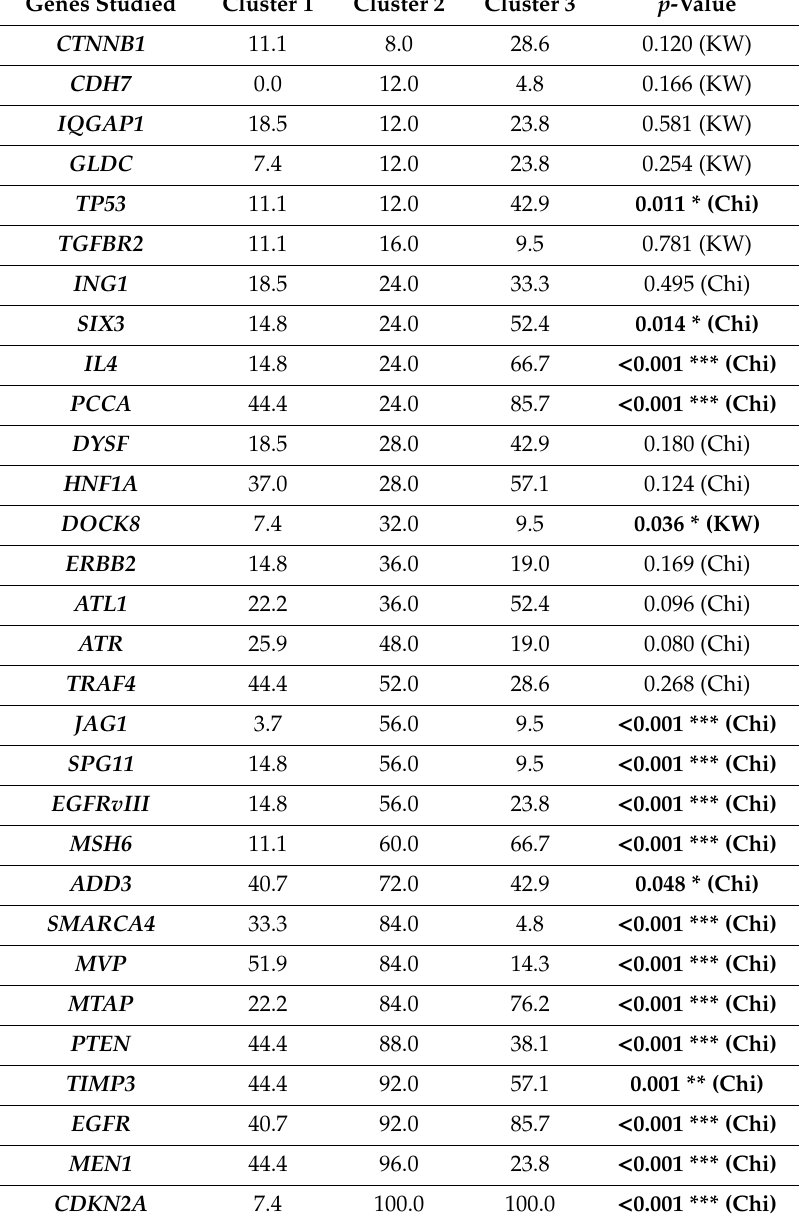
Table 3. Clustering analysis of GBM